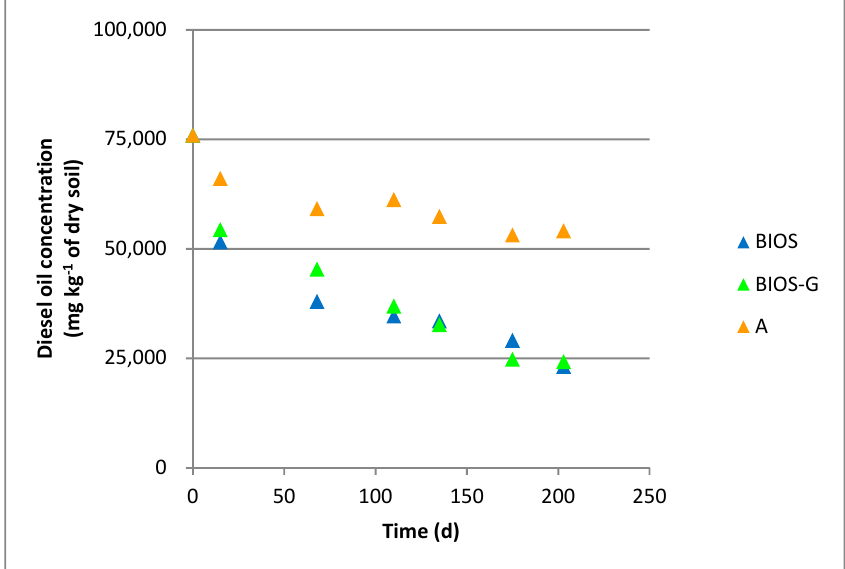
Figure 5. Residual diesel oil concentration in microcosms’ respiration (A = abiotic microcosm; BIOS = biostimulated microcosm; BIOS-G = biostimulated microcosm and glucose addition).